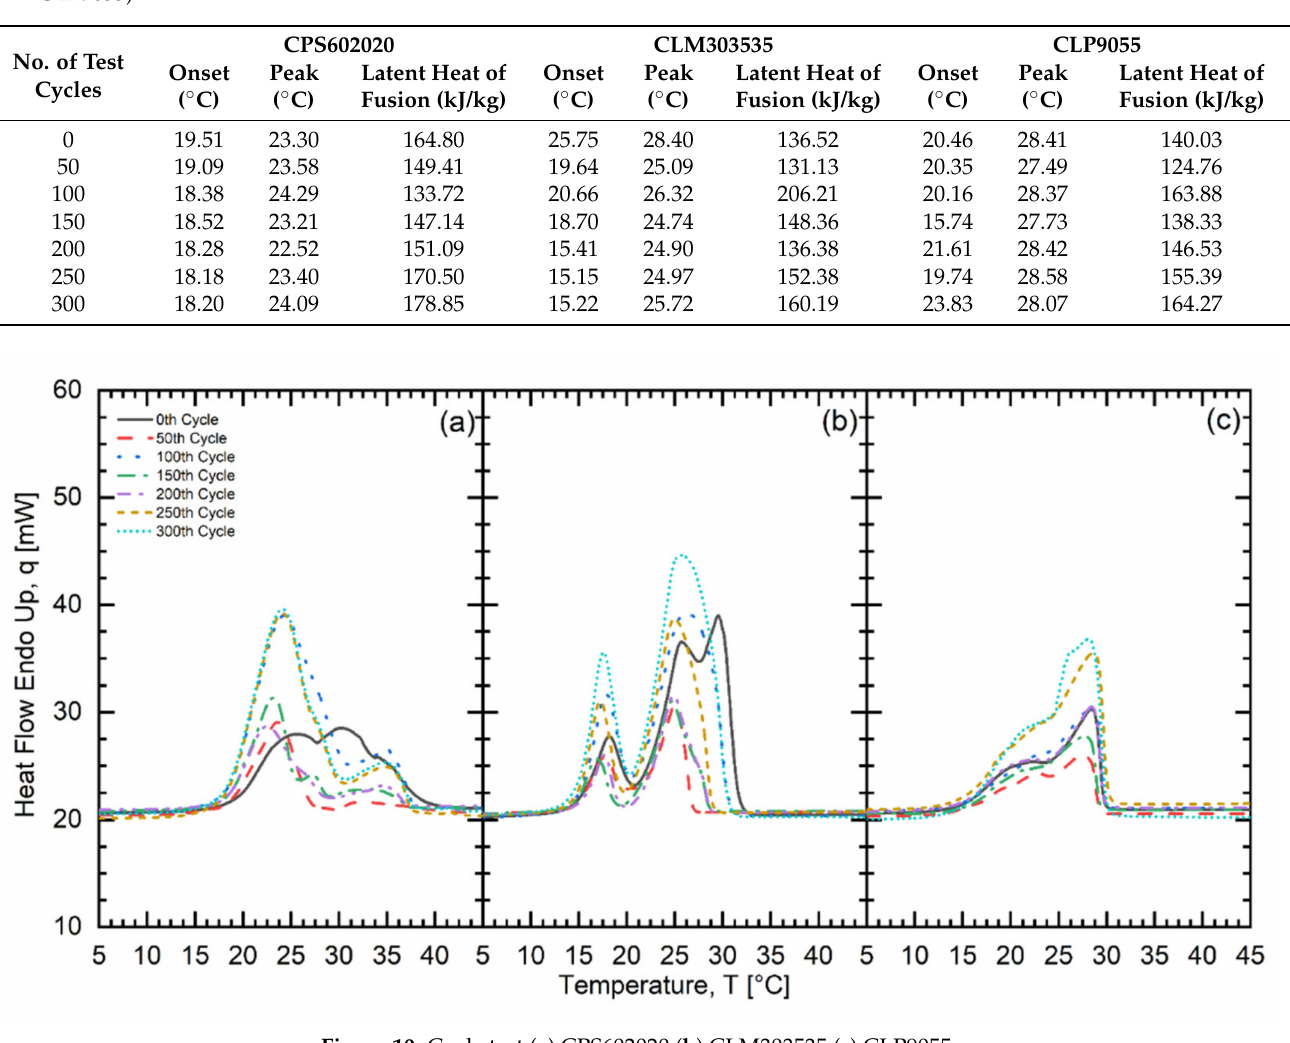
Figure 10. Cycle test ( a ) CPS602020 ( b ) CLM303535 ( c )